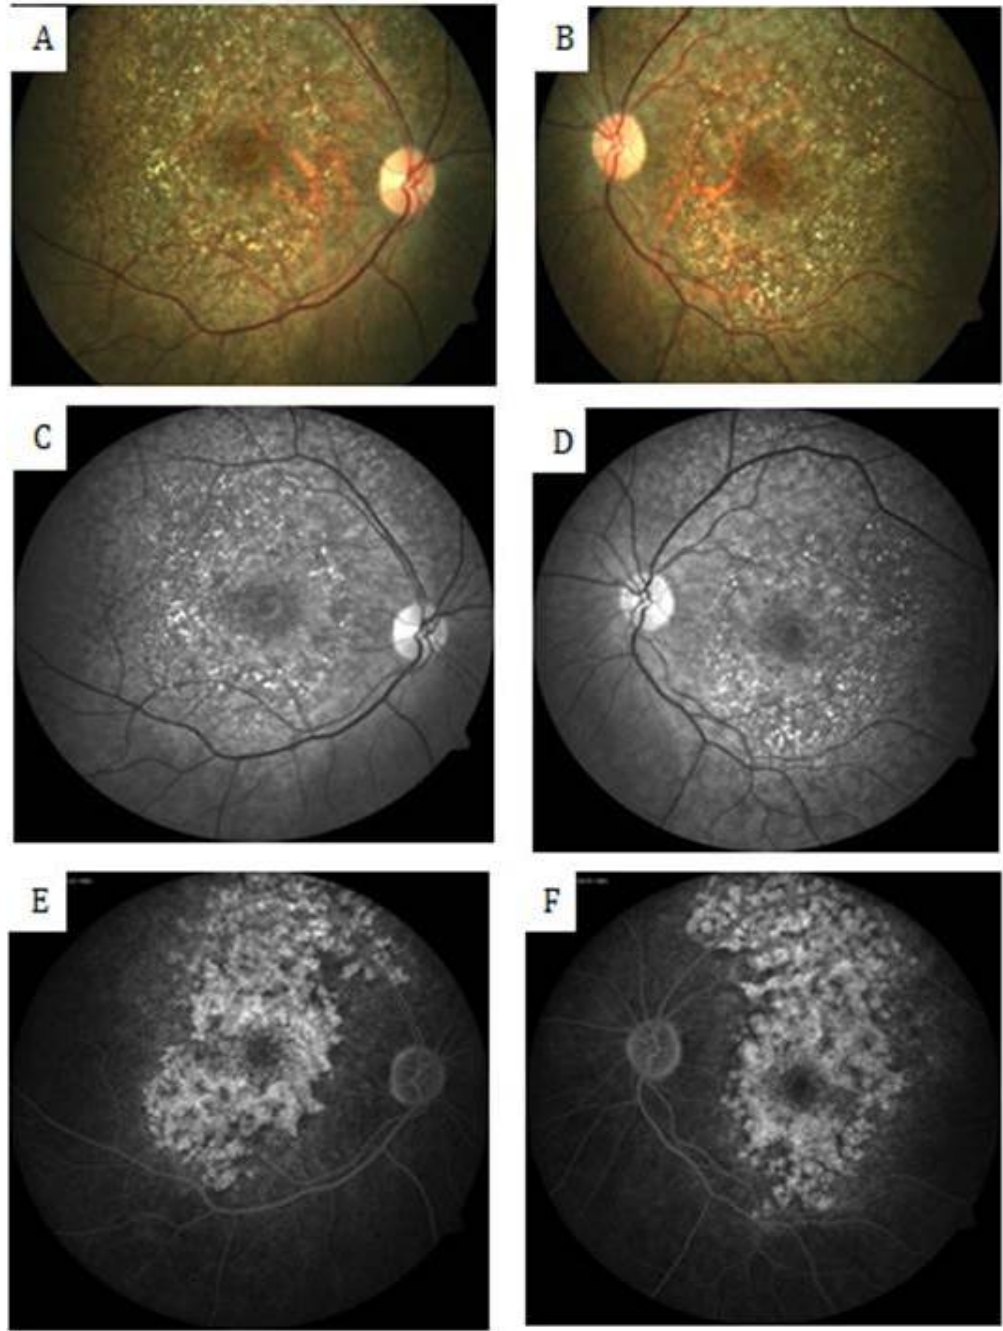
Figure 1: A, B) Retinal pigment epithelium mottling around the macular and para-macular area in fundus photo C, D) Dark patches at the macular region in fundus autofluorescence (FAF) E, F) Hyperfluorescence observed at macula and surrounding macular region in fundus fluorescein angiography